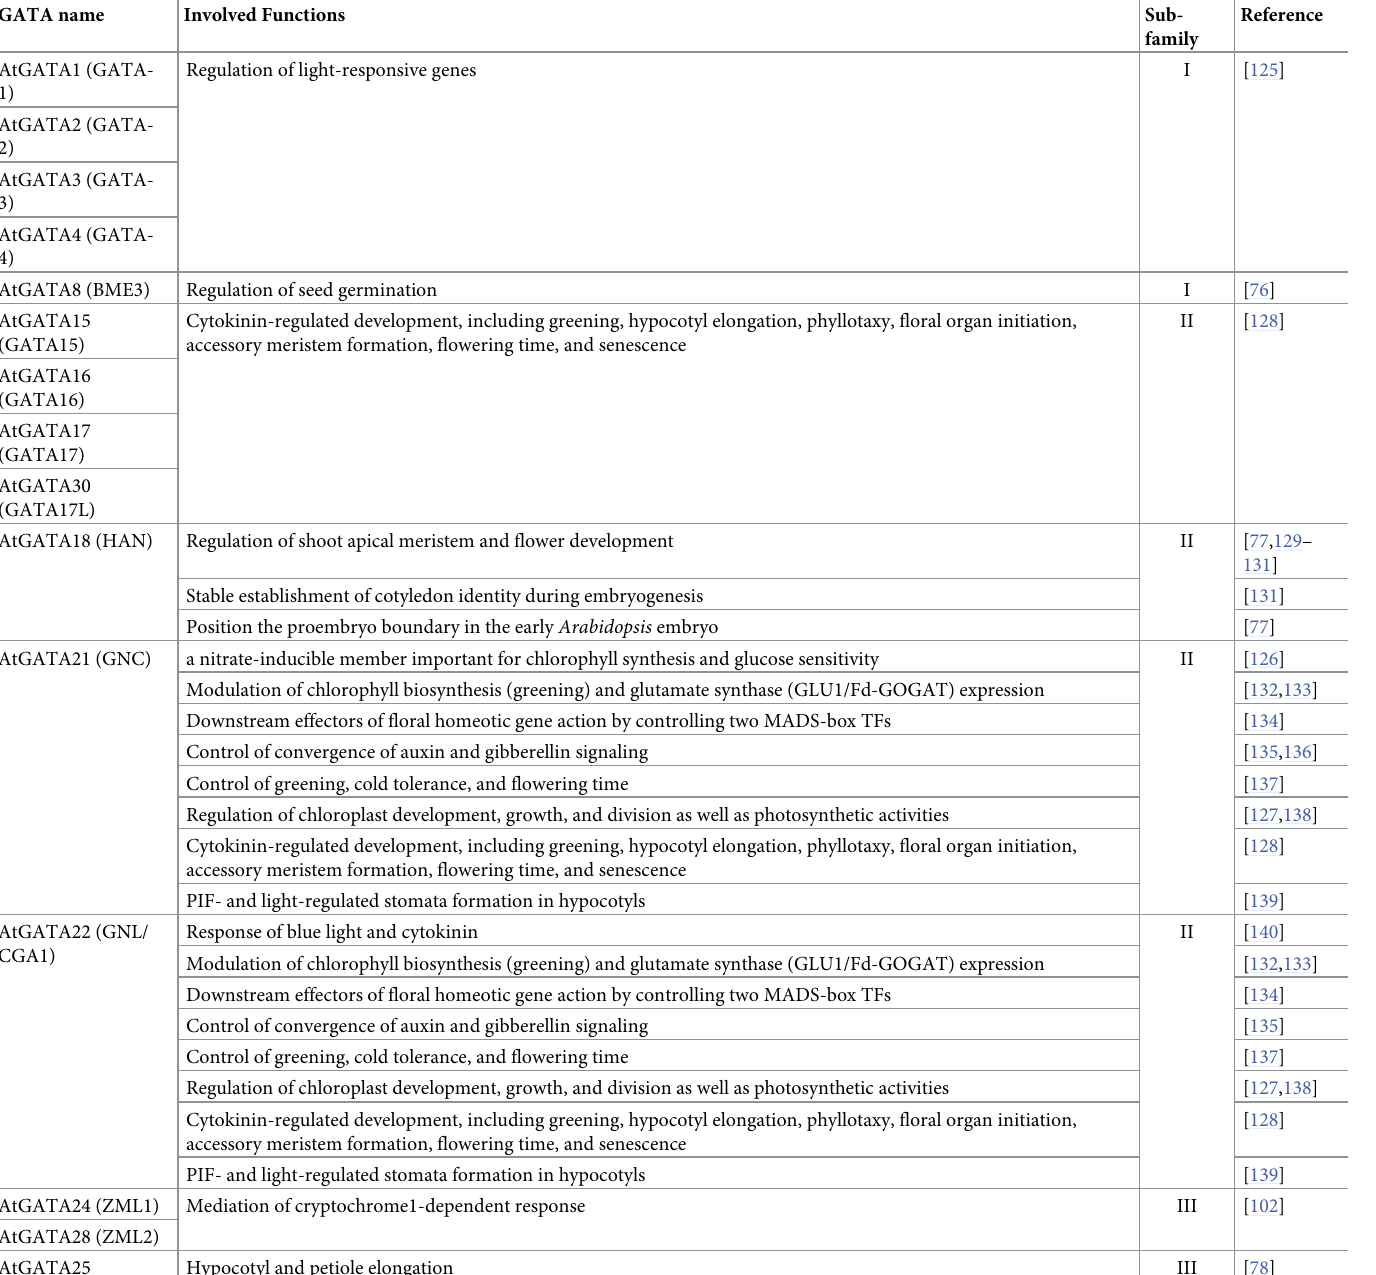
Table 7. Characterized GATA genes in A . thaliana Col0. GATA